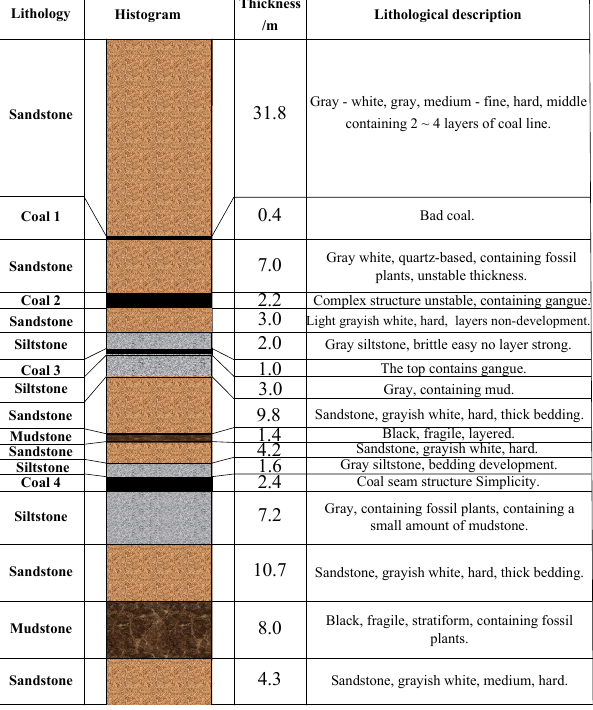
Figure 2. Schematic diagram of roadway support.